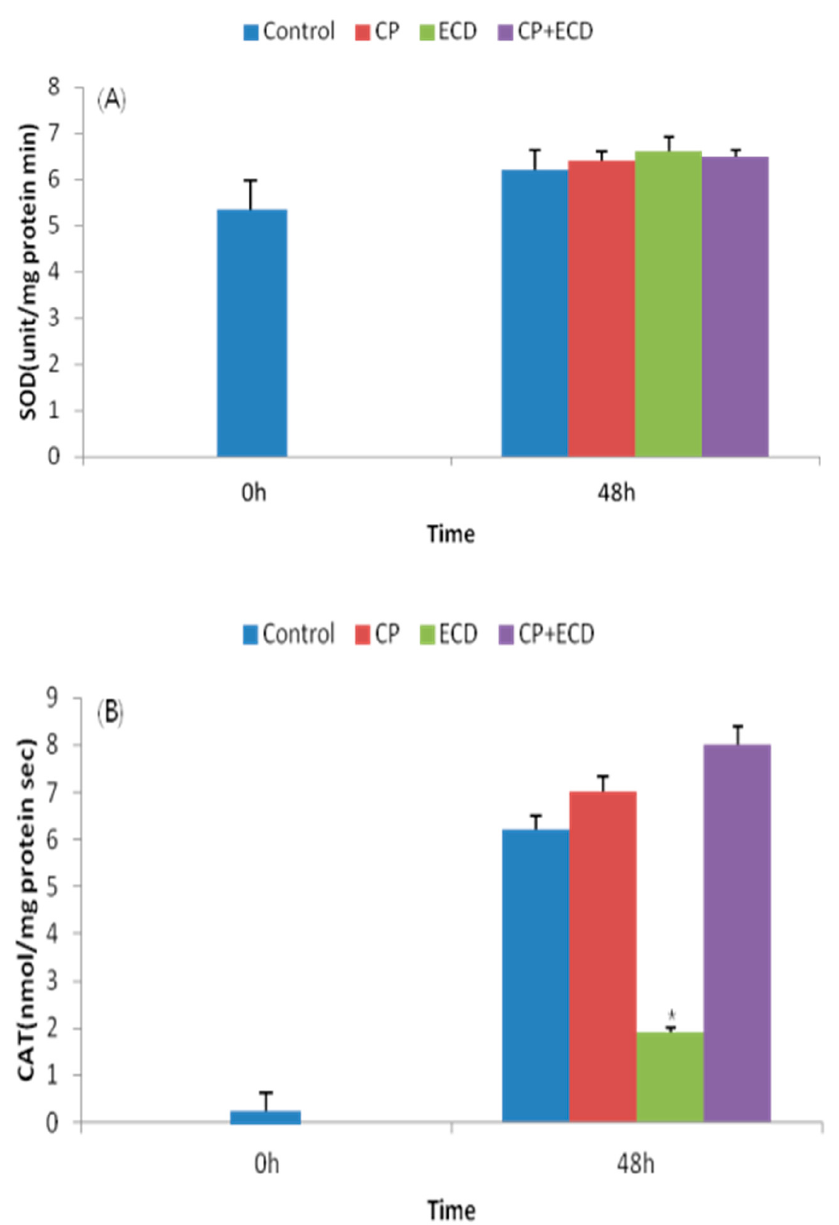
Figure 3. Effect of acute water-salinity stress for 48 h on the change of superoxide dismutase (SOD) ( A ) and catalase (CAT) levels ( B ) in the abalone ( H. discus ). This was assessed after they were fed on the experimental diets supplemented with CP (6%), ECD (6%), and CP + ECD (3% + 3%) for 12 weeks. Vertical bars represent the SE of the means of three experiments. * p < 0.05 for the control level at 48 h.